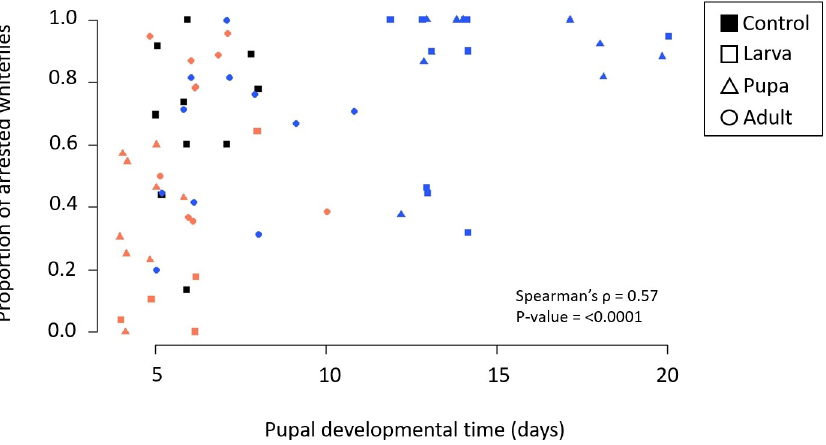
Fig 6. Correlation between CI strength (as denoted by the proportion of arrested whiteflies) and the duration of the pupal stage of male E . suzannae . Points refer to development time and corresponding offspring mortality for individual males used in CI crosses. The color of points denotes temperature range (black = 27˚C, red = 32–29˚C, blue = 20–17˚C). Treatments are also separated by the stage at which temperature exposure began ( □ = Larva, Δ = Pupa, O =